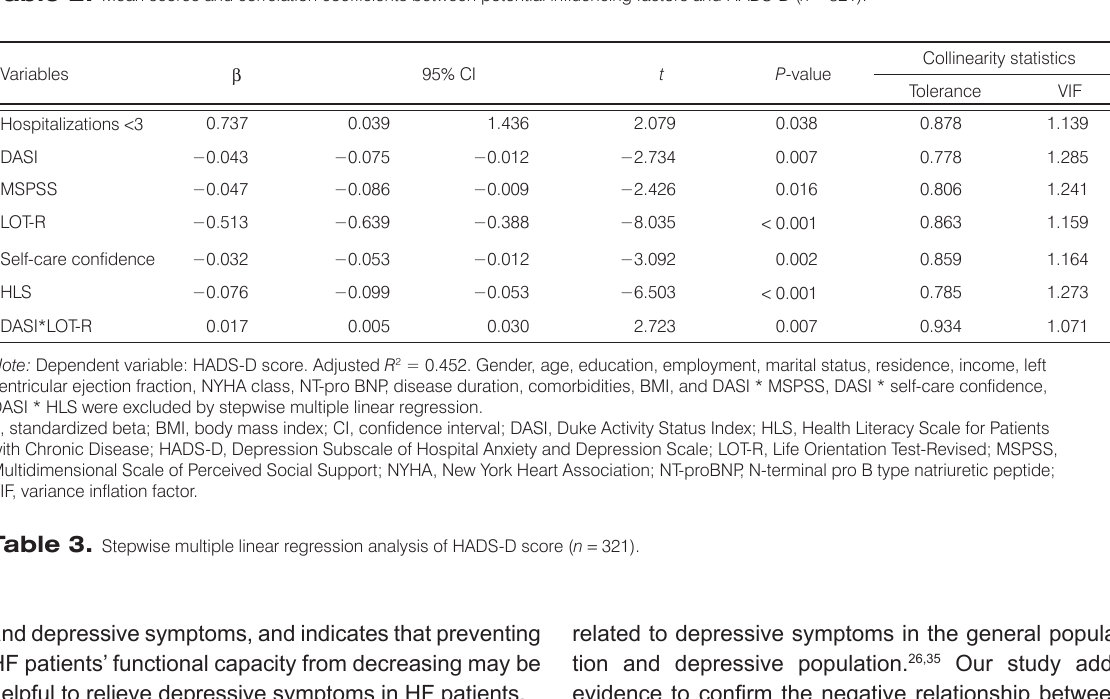
Table 3. Stepwise multiple linear regression analysis of HADS-D score ( n =